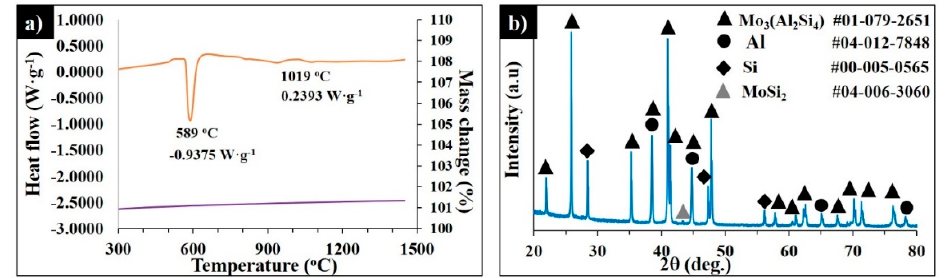
Figure 10. DSC-TG curves of MoSi 2 -30 wt.% AlSi10Mg heated up to 1450 °C at 20°·min − 1 in Ar ( a ) and the corresponding XRD pattern of the quenched sample ( b ).